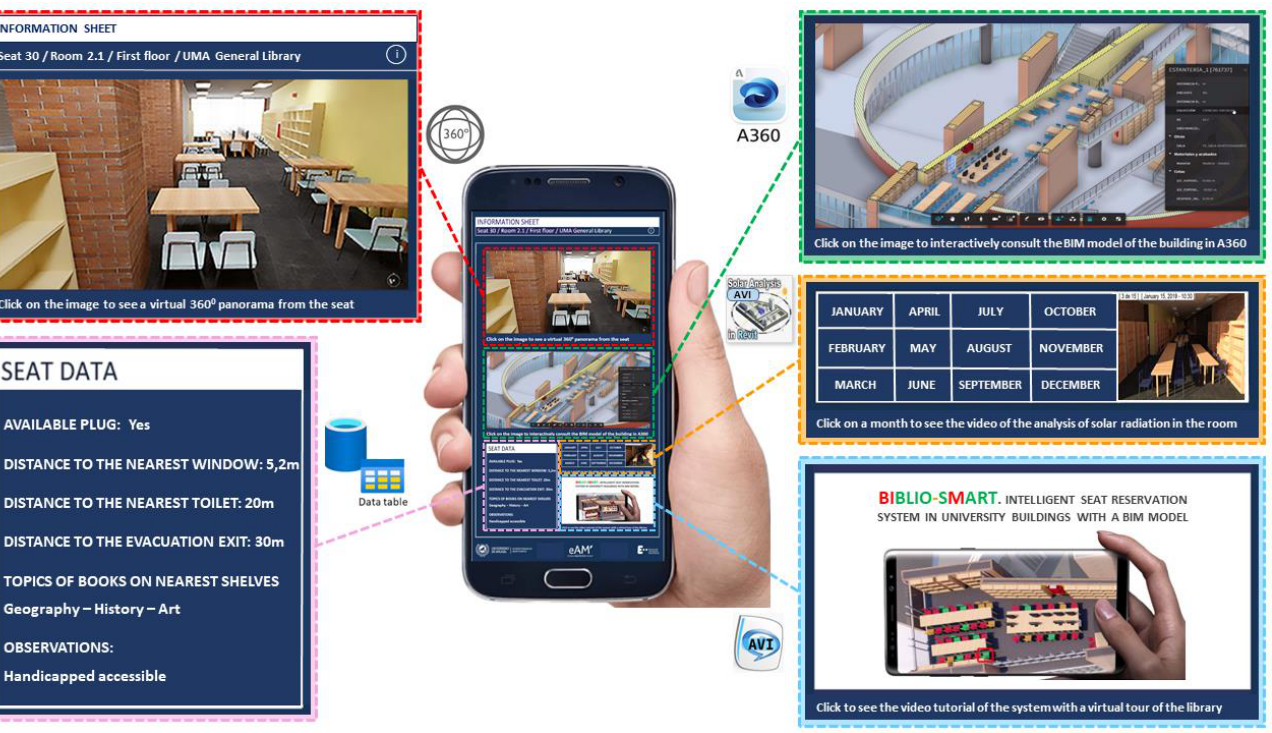
Figure 10. Biblio-Smart app interface designed to consult information of interest for the reservation from BIM model data, with its expanded options and icons of the file format or tool used.